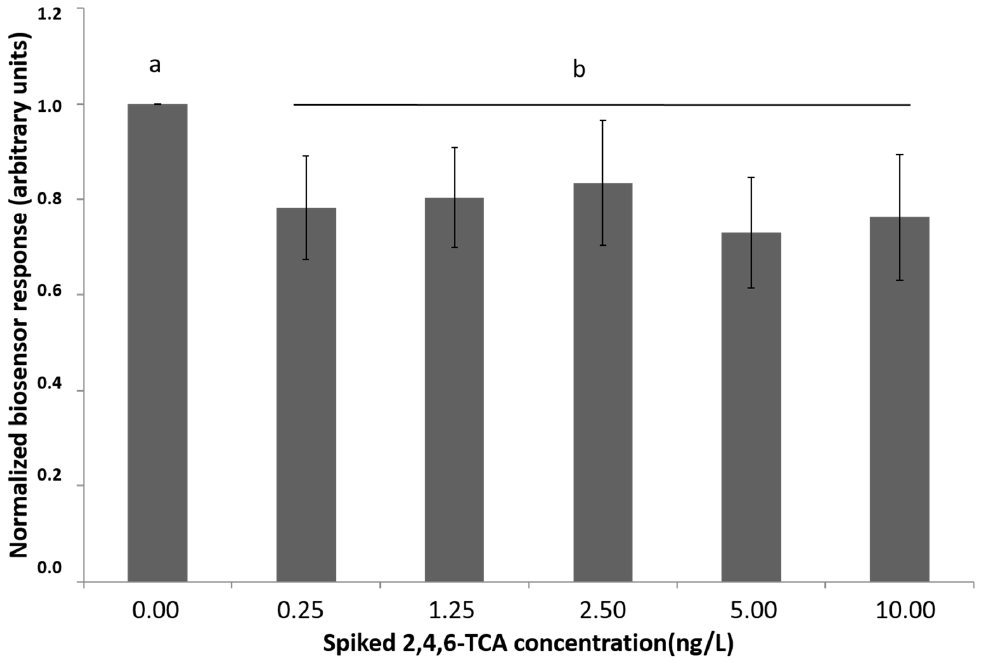
Figure 4. Average normalized biosensor responses against the different spiked 2,4,6-TCA concentrations using cellular biorecognition elements membrane-engineered with 0.5 ng/L anti-TCA antibody ( n = 24 replications for each concentration, and error bars represent the standard errors of the average value of all replications with each range of concentration). Different letters (a, b) indicate statistically significant different values ( p < 0.01).